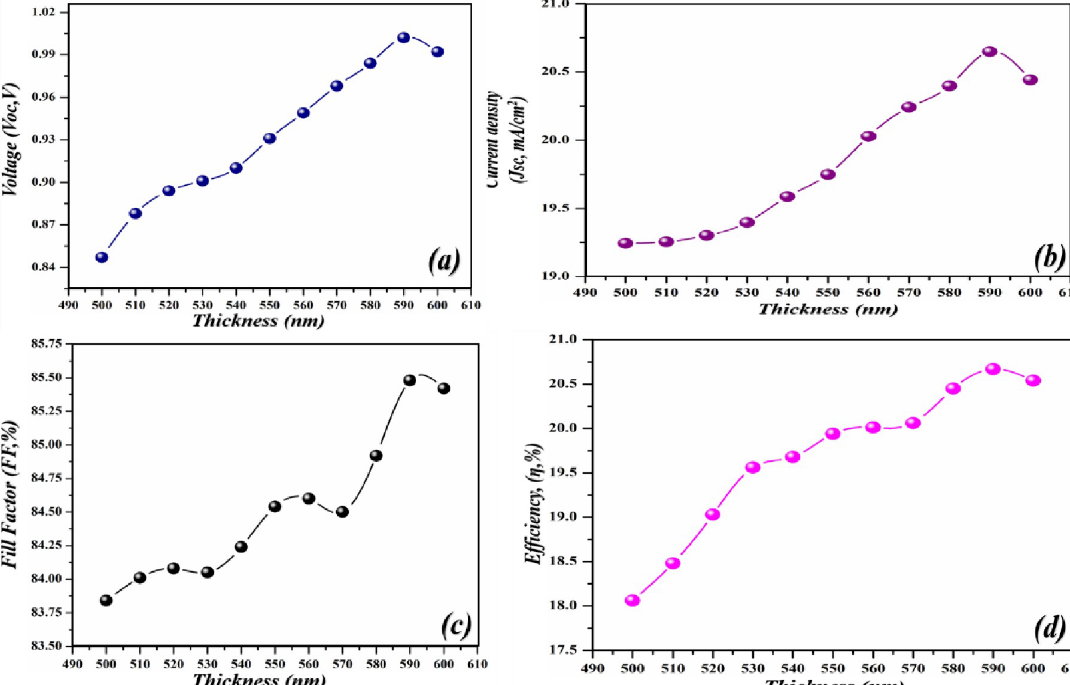
Fig 10. Simulated photovoltaic parameters of novel geometry (a) V oc as an independent function of light-harvesting layer, (b) J sc as an independent function of a light-harvesting layer (c) FF as an independent function of light-harvesting layer (d) PCE as an independent function of light-harvesting